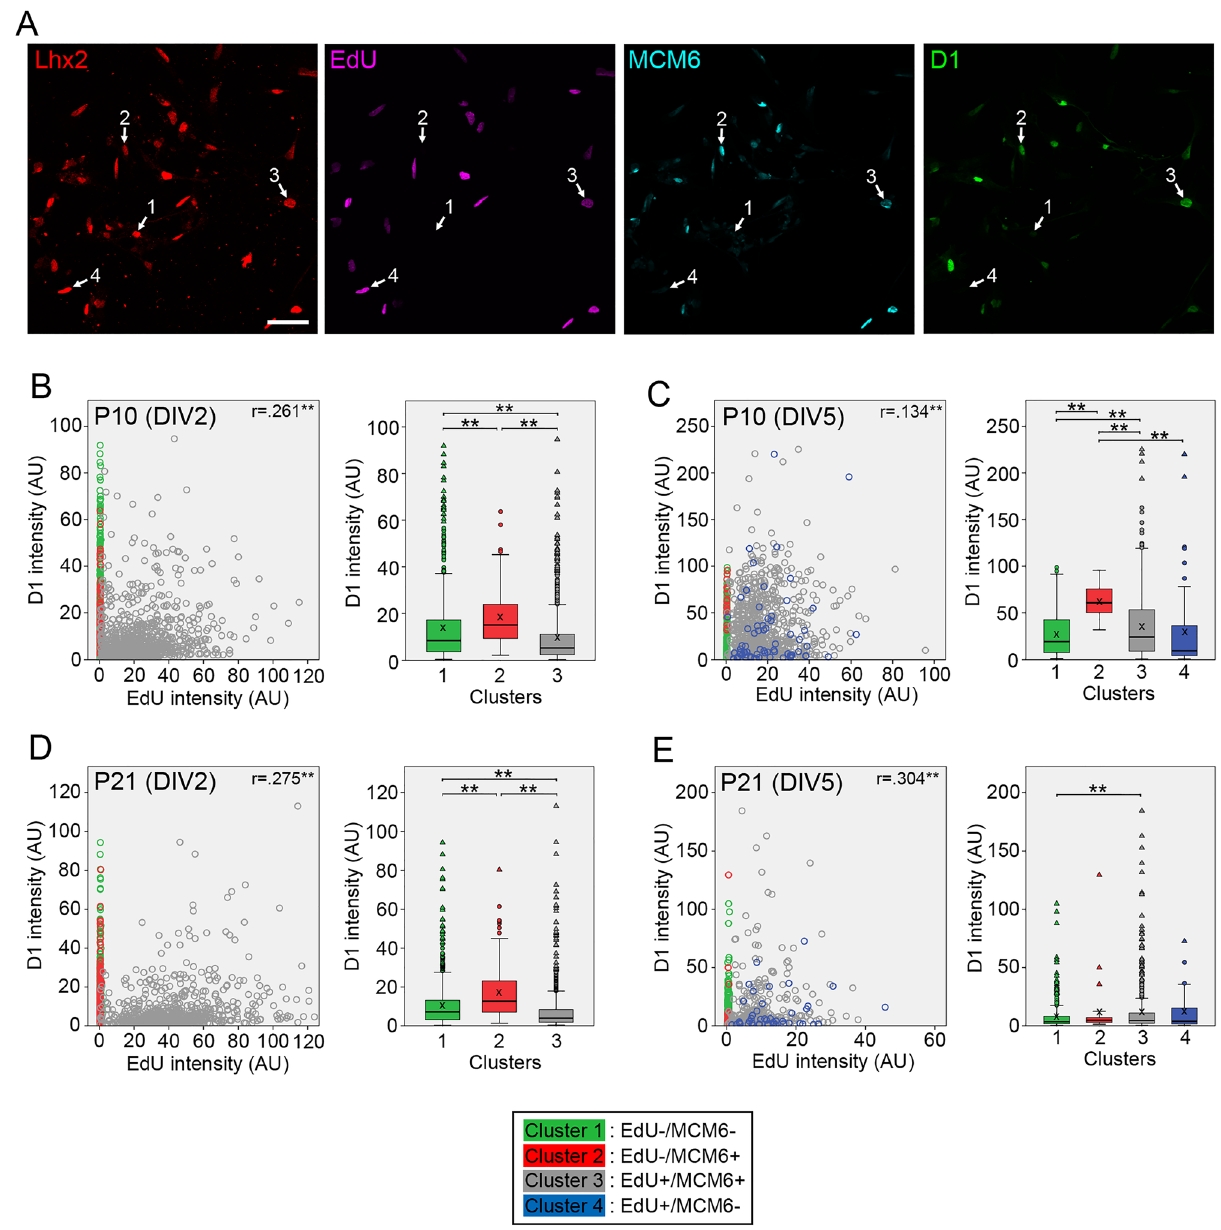
Figure 7. Quantitative analyses of cyclin D1 expression in Müller glia dissociated from P10 and P21 mouse retinas. Intensities of EdU, MCM6 and cyclin D1 labeling in Lhx2 + Müller glia were quantitated by image analysis and cyclin D1 levels in Müller glia classified into four clusters are shown as scatter plots and box plots. ( A ) Confocal images of quadruple labeling for Lhx2, EdU, MCM6 and cyclin D1 in Müller glia from P10 retina at DIV5. The numbers represent the clusters. Scale bar = 50 µm. ( B ) Plots of 1745 Müller glia from P10 retina at DIV2. ( C ) Plots of 1021 Müller glia from P10 retina at DIV5. ( D ) Plots of 1867 Müller glia from P21 retina at DIV2. ( E ) Plots of 921 Müller glia from P21 retina at DIV5. AU arbitrary units. r , Spearman’s correlation coefficients between cyclin D1 and EdU intensities in the cluster 3. X in box plots indicates the mean. * P < 0.05, ** P <